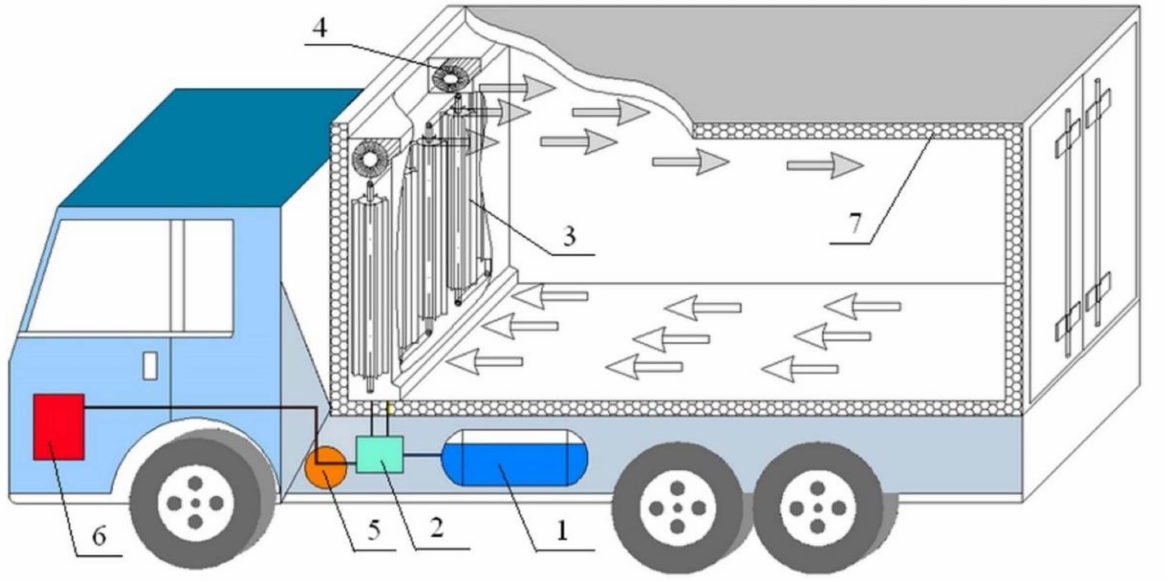
Figure 13. The schematic diagram of a light-duty LNG-chilled refrigerated vehicle 1, LNG tank; 2, Valves box; 3, Cold energy recovery heat exchanger; 4, Induced draft fan; 5, Superheater; 6, Engine; 7, Refrigerated vehicle body. Reprinted from ref. [48], Copyright (2014), with permission from